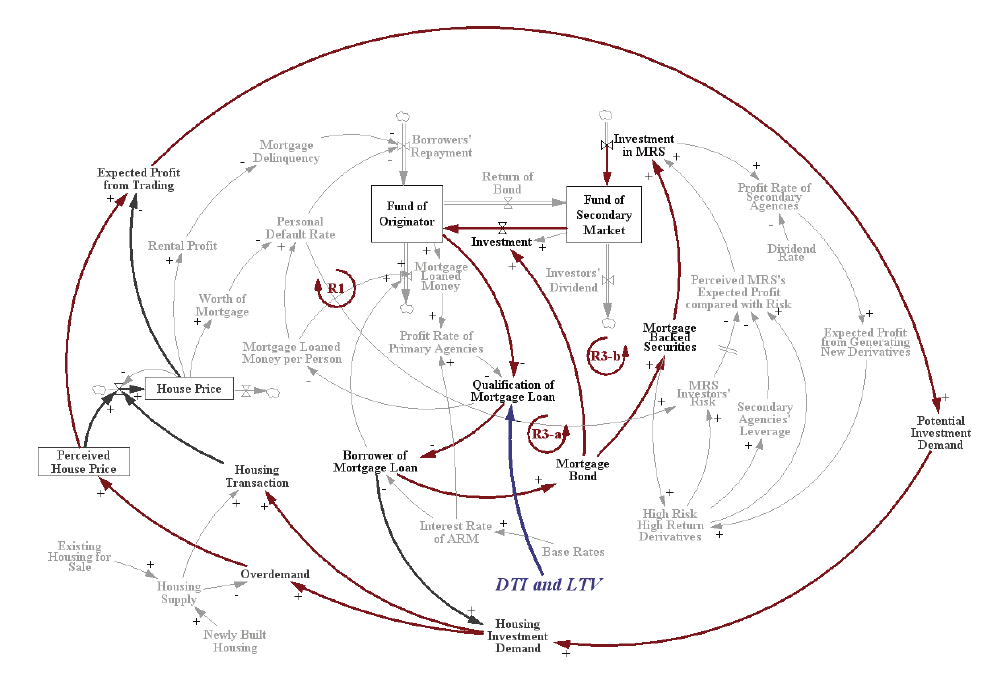
figure 10. Government expectation of policies’ effects